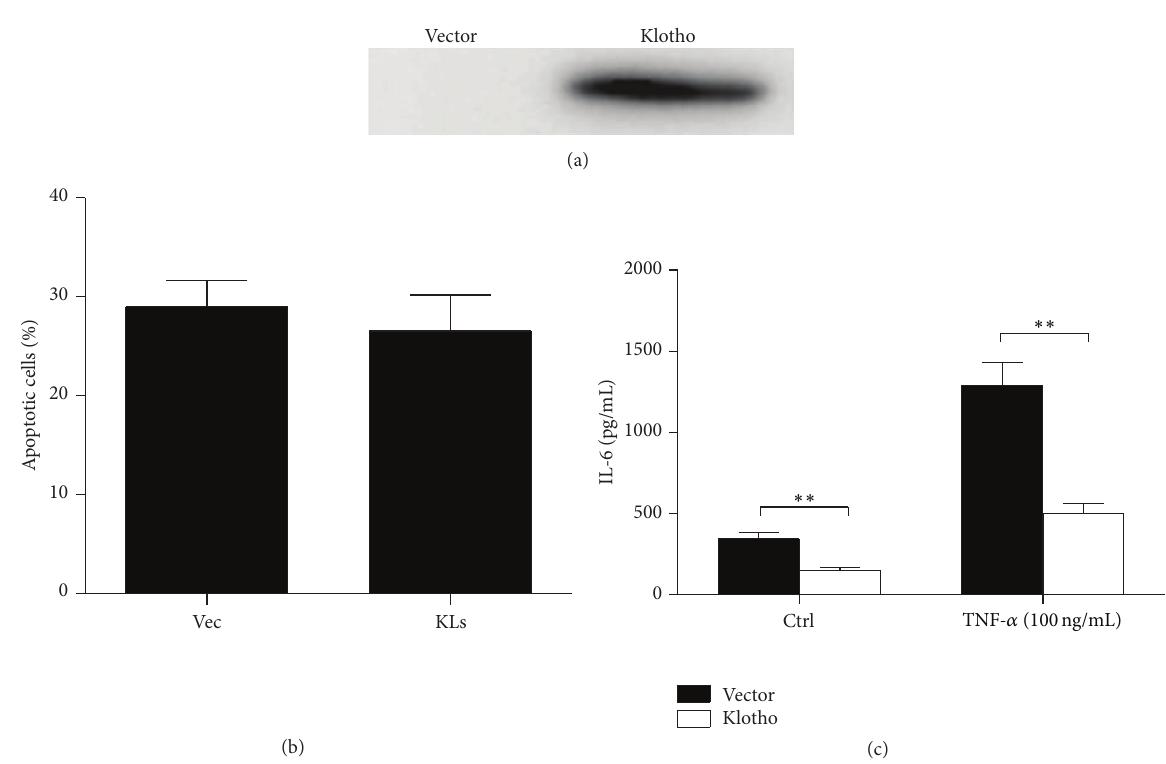
Figure4:OverexpressionofklothoinHUVECsreducedIL-6productionwithorwithoutTNF- 𝛼 administration.(a)Westernblottinganalysis demonstrated a robust overexpression of klotho in HUVECs. (b) Apoptotic analysis. (c) ELLISA assay of IL-6 in medium of HUVECs with or without TNF- 𝛼 treatment. The values represent the means ± SDs ( 𝑛 = 4 in each group). ∗∗ 𝑝 < 0.01 versus vector